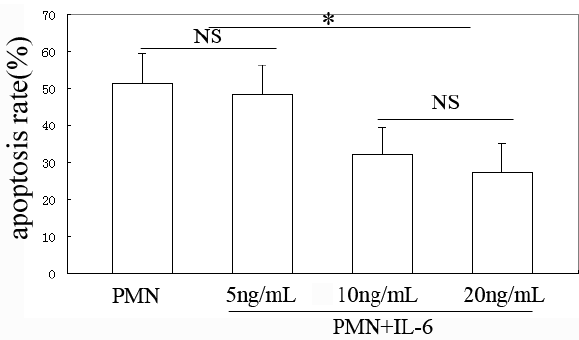
Figure 3: IL-6 at the concentration of 10ng/ml and 20ng/ml could inhibit PMN apoptosis statistically. However, IL-6 at the concentra- tion of 5ng/ml could not inhibit the apoptosis of PMN. *: P <0.05. NS: not significant. Data are expressed as mean ± SD of triplicates from six independent